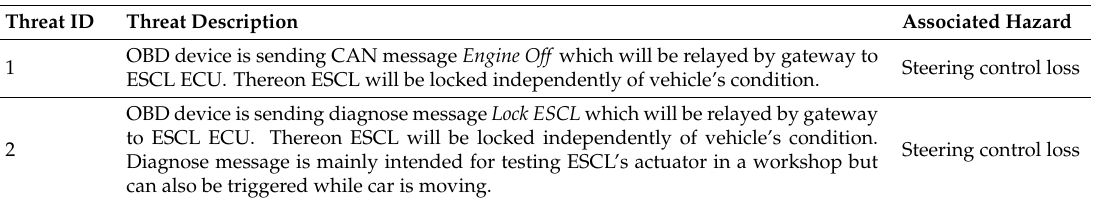
Table 7. Threats regarding to Figure